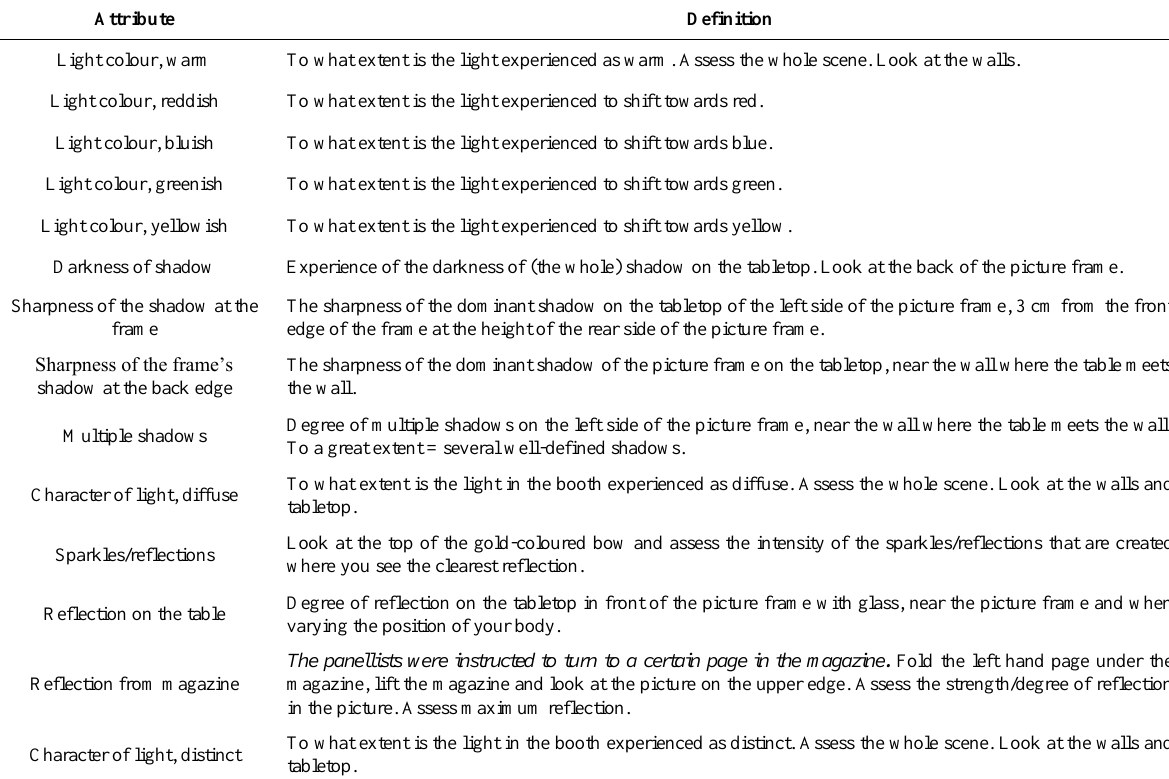
Character of light,